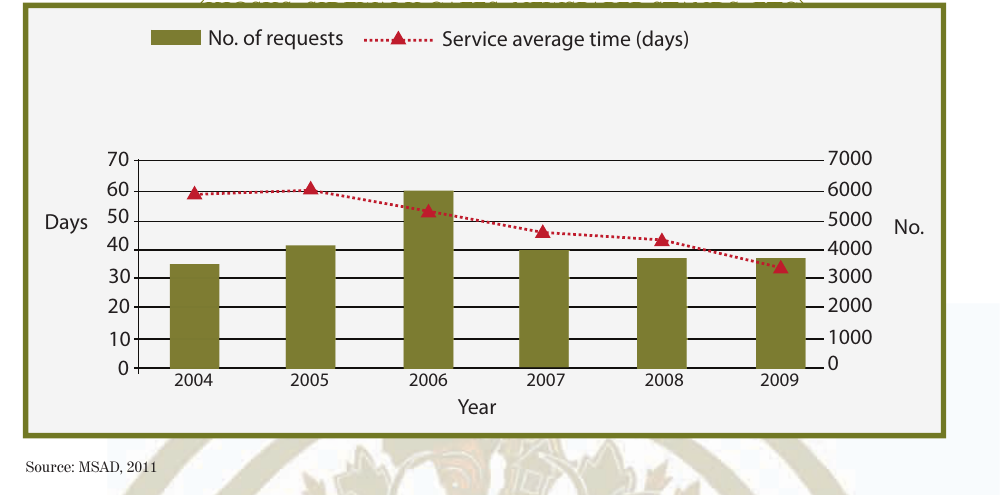
FIGURE 5: RETAIL SHOP